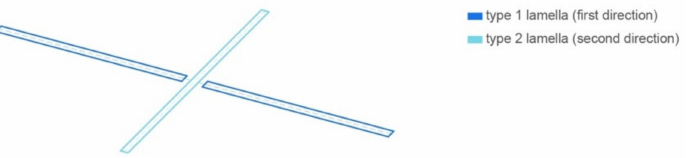
Figure 4. Diagram showing the node with one central lamella and two connecting lamellae when lamellae axes